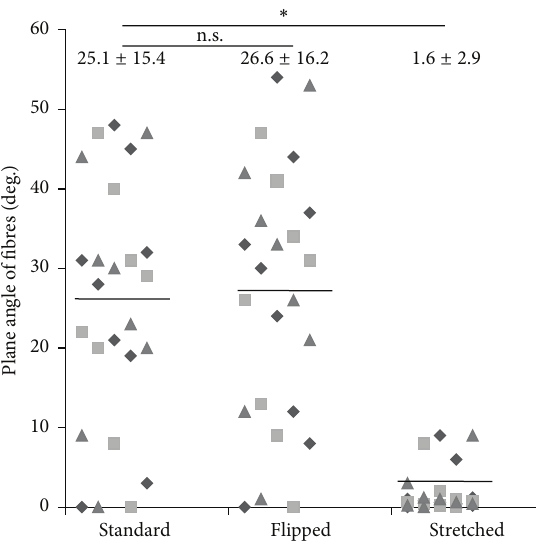
Figure 4: “Stretched” cell culture conditions realigned matrix fibres with the horizon. Masson’s trichrome stained slices of tissue were analyzed to determine the plane angle of the matrix fibres. (No fibre was found to have an angle superior to 60 degrees.) Distribution of plane angle of standard, “flipped,” and “stretched” conditions was presented. The bars correspond to the mean also reported with standard deviation on the top of the graph. Triangles, squares, and diamonds represent value of the plane angle of the fibres in the samerepresentativeexperiment.n.s.isfornotstatisticallysignificant different compared values and ∗ is for statistically significant different compared values.